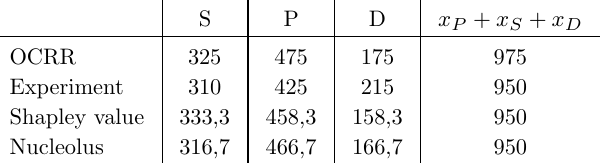
The comparison of OCRR and experimental results with the Shapley value and nucleolus for the jazz band game with an empty core